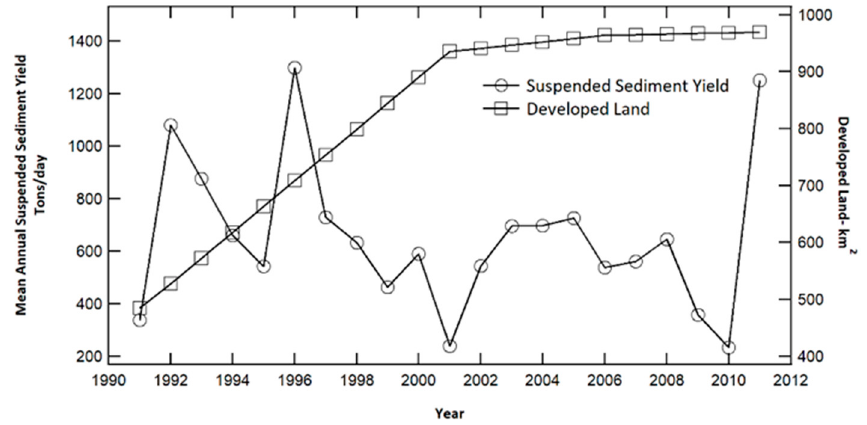
Figure 5. Variation in suspended sediment yield and land development.